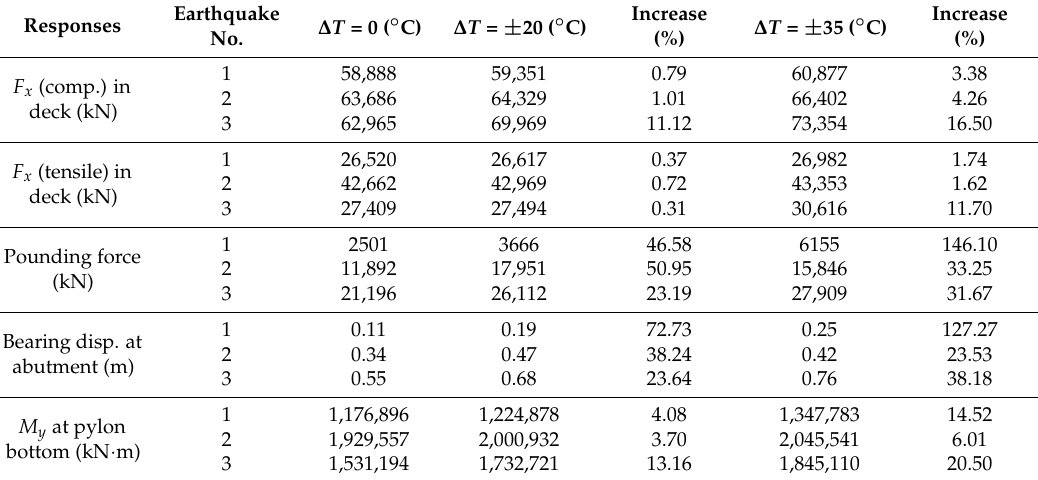
Table 3. Seismic responses of the bridge with varying